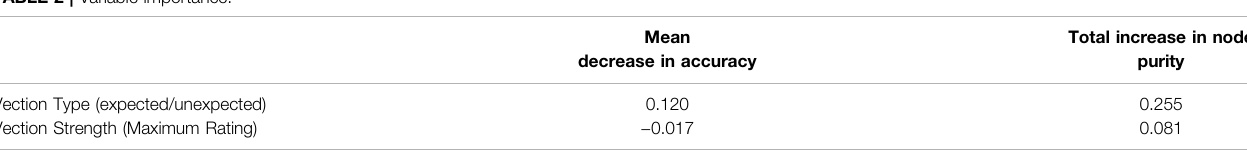
TABLE 2 | Variable